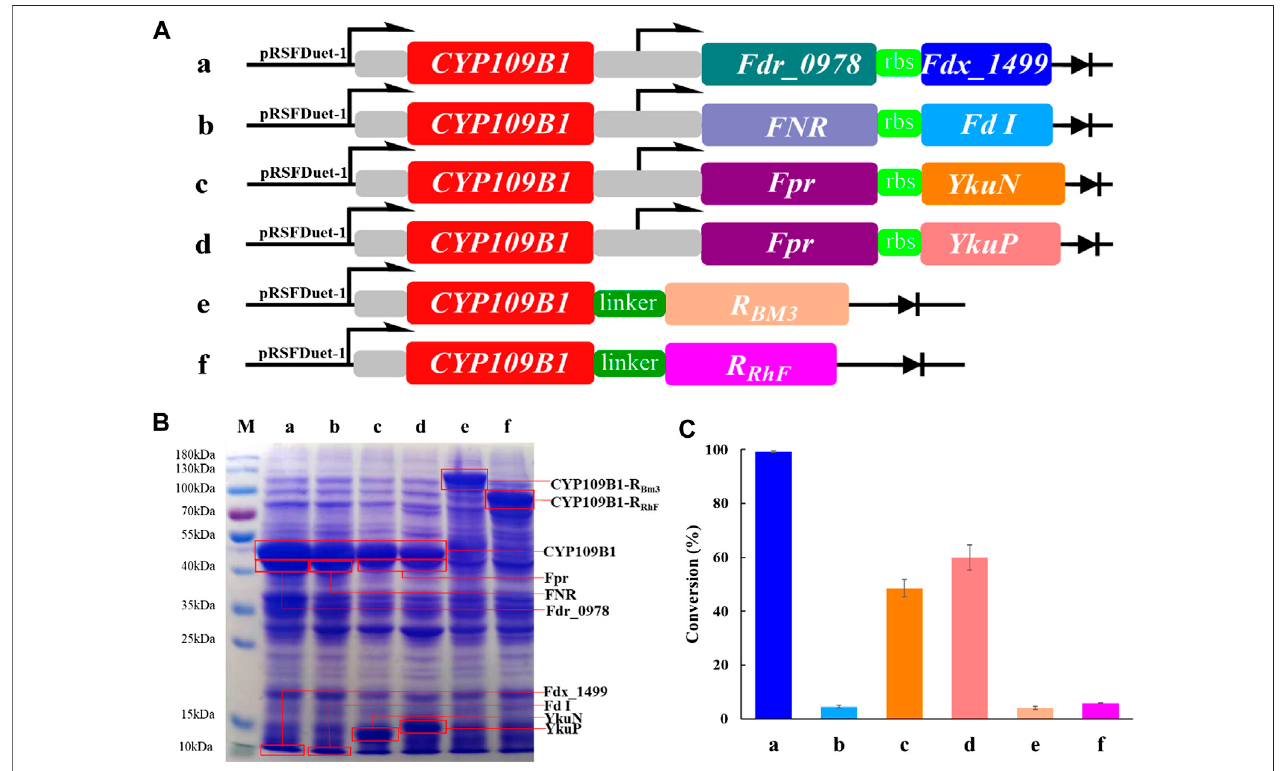
FIGURE 1 | (A): The con fi guration of plasmids containing CYP109B1 with different pairs of redox partners (ferredoxin and ferredoxin reductase) or plasmids containingfused enzyme byfusing theheme domain ofCYP109B1 toreductase domain ofP450BM3or P450RhF. a : plasmid pRSFDuet-1containing CYP109B1 and Fdr_0978/Fdx_1499 redox partner, b : plasmid pRSFDuet-1 containing CYP109B1 and FNR/Fd I redox partner from spinach , c : plasmid pRSFDuet-1 containing CYP109B1andFpr/YkuN, d :plasmidpRSFDuet-1containingCYP109B1andFpr/YkuP, e :plasmidpRSFDuet-1containingfusedenzymeP450CYP109B1-BM3 in which heme domain of CYP109B1 was fused to the reductase domain of P450 BM3 from Bacillus megaterium , f : plasmid pRSFDuet-1 containing fused enzyme P450CYP109B1-RhFRed in which heme domain of CYP109B1 was fused to the reductase domain of P450RhF from Rhodococcus sp. Strain NCIMB 9784. (B) : SDS- PAGE analysis of recombination E. coli cells containing the corresponding plasmids in Figure 1A . (C) : Conversion of testosterone with whole-cell catalyst expressing different reconstituted catalytic system. Reaction conditions: recombinant E. coli cells frozen with liquid nitrogen was suspended in phosphate buffer (pH 8.0, 100 mM, OD 600 (cid:2) 20) containing 1 unit glucose-6-phosphate dehydrogenase, 5 g/L glucose-6-phosphate, 5 g/L glycerol and 1 mM NADP + , reactions were conducted at 25 ° C, 200 rpm for 20